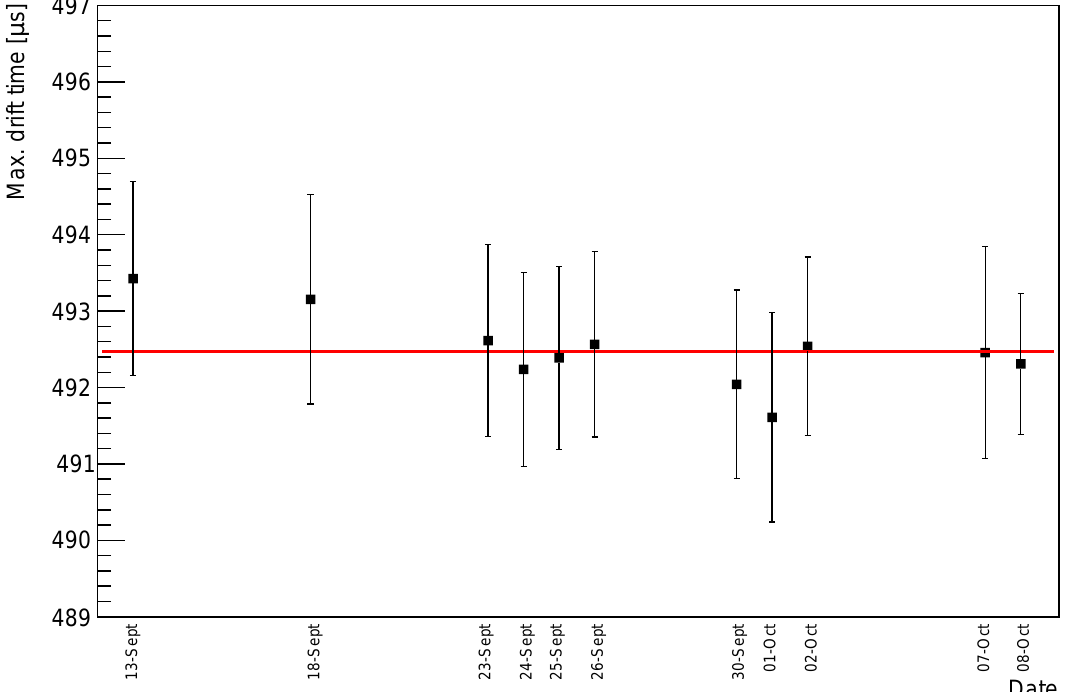
Figure 7. The maximum possible drift time t d , as calculated for a series of datasets taken over a period of several weeks. The error bars correspond to the width parameter of each dataset’s fitted Landau function. The mean value across all datasets is shown in